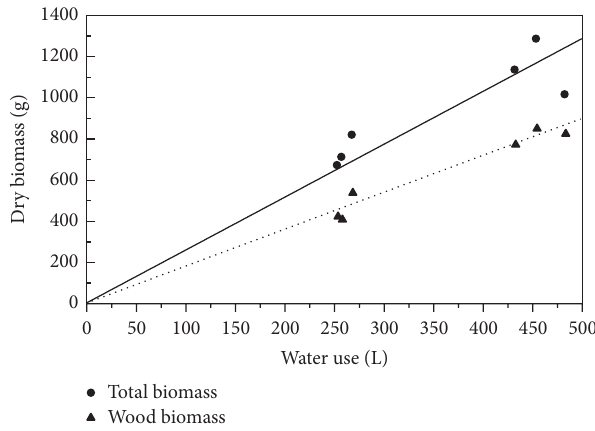
Figure 11: Water use efficiency under different drought stress durations, for the dry wood and the dry total aboveground